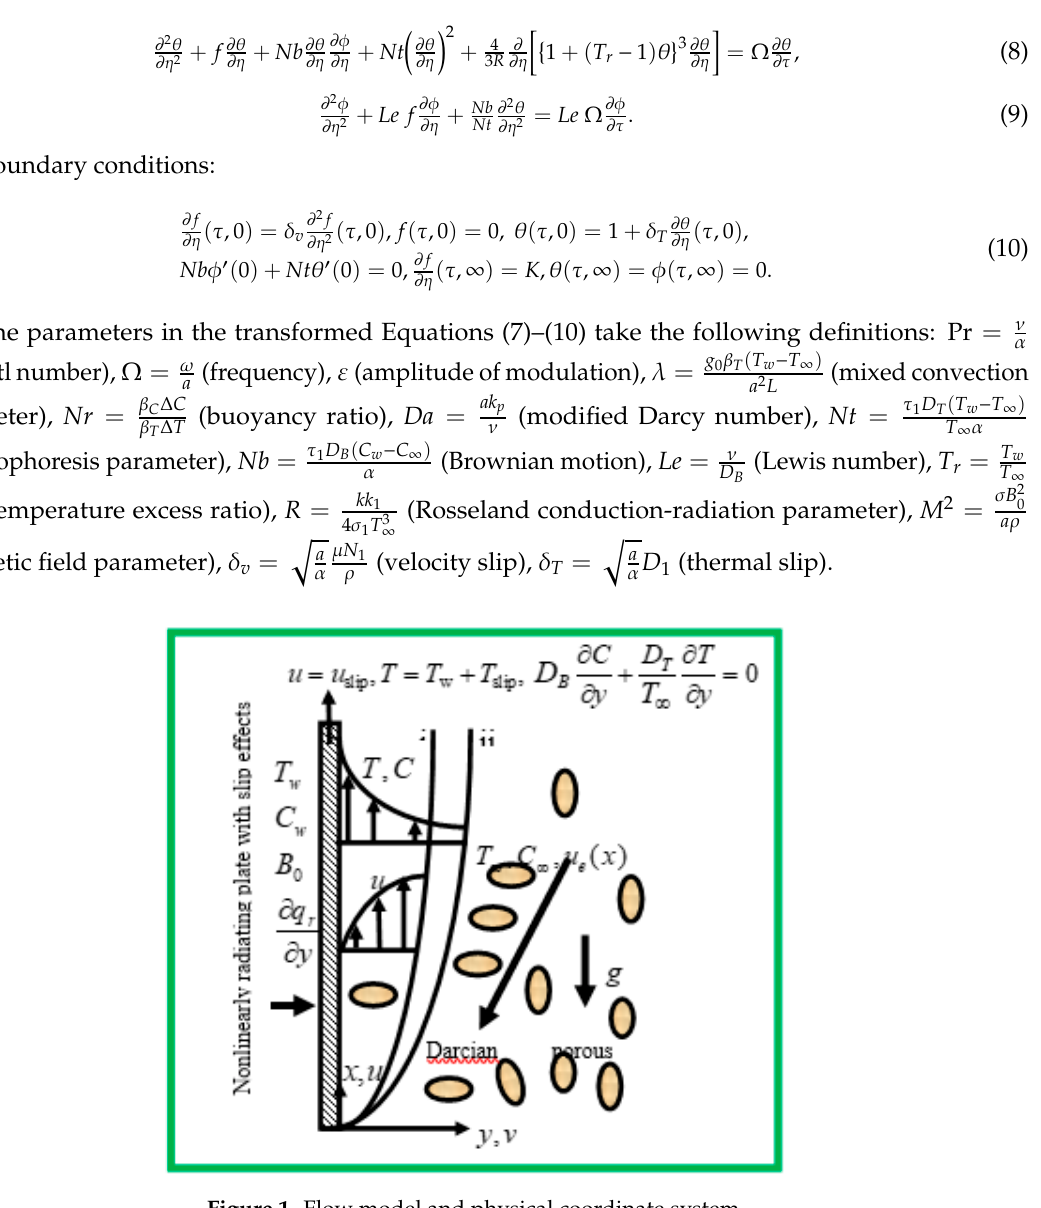
Figure 1. Flow model and physical coordinate system.